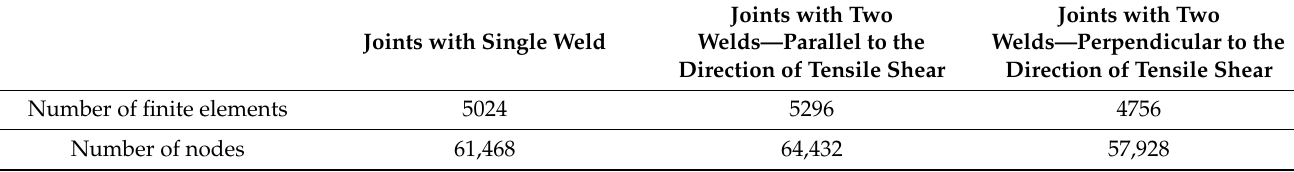
Table 5. The total number of finite elements and nodes of the models. Joints with Two Joints with Joints with Single Weld